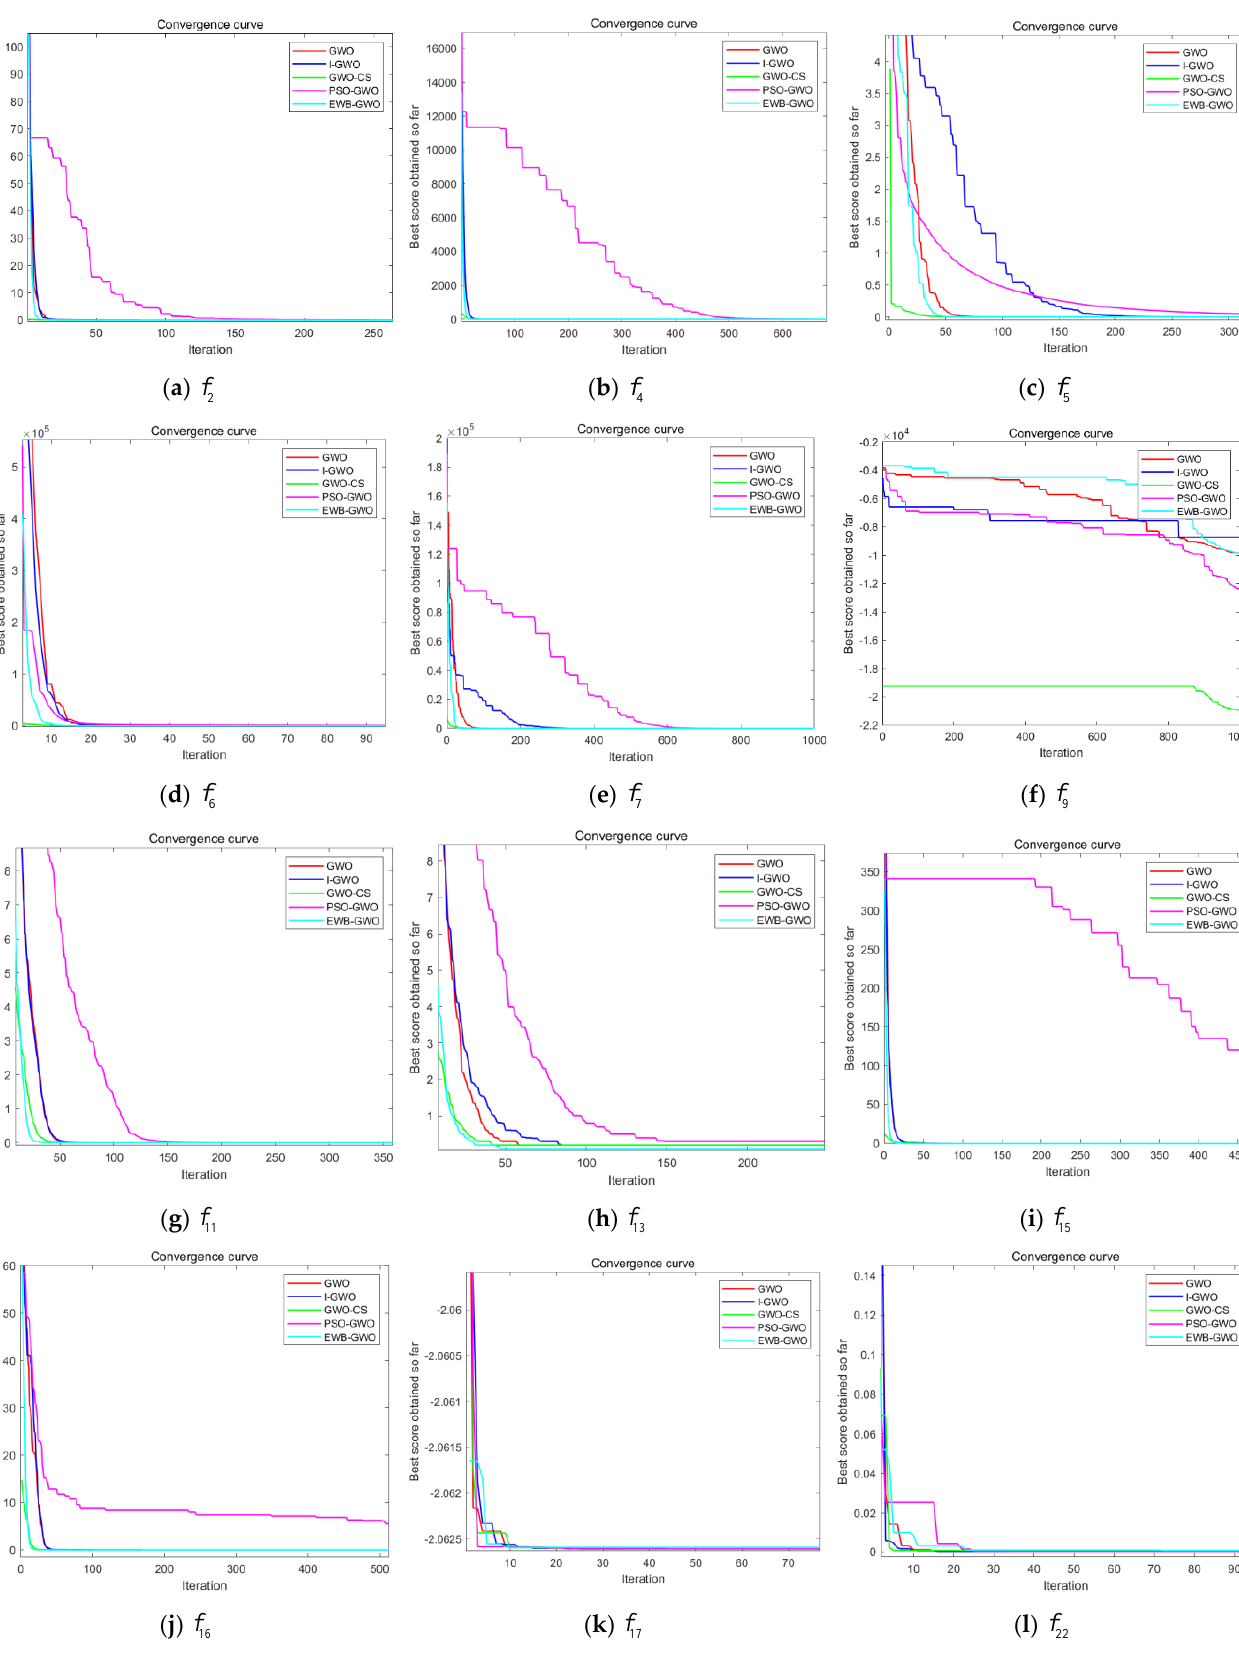
Figure 13. Comparison of convergence curves of GWO, I − GWO, GWO − CS, PSO − GWO, and EWB − GWO.